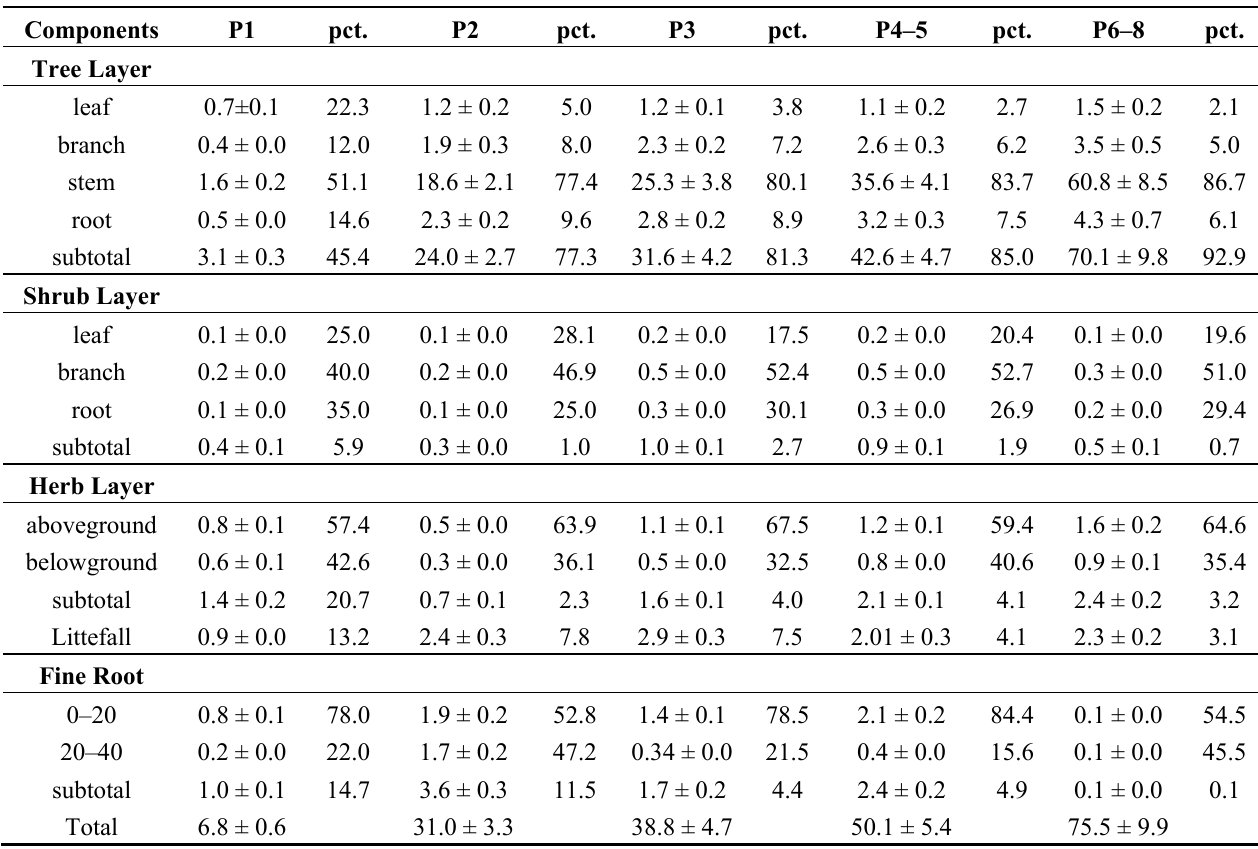
Table 3. Biomass carbon (C) storage (Mg ha − 1 ) in different components of the Eucalyptus plantation.